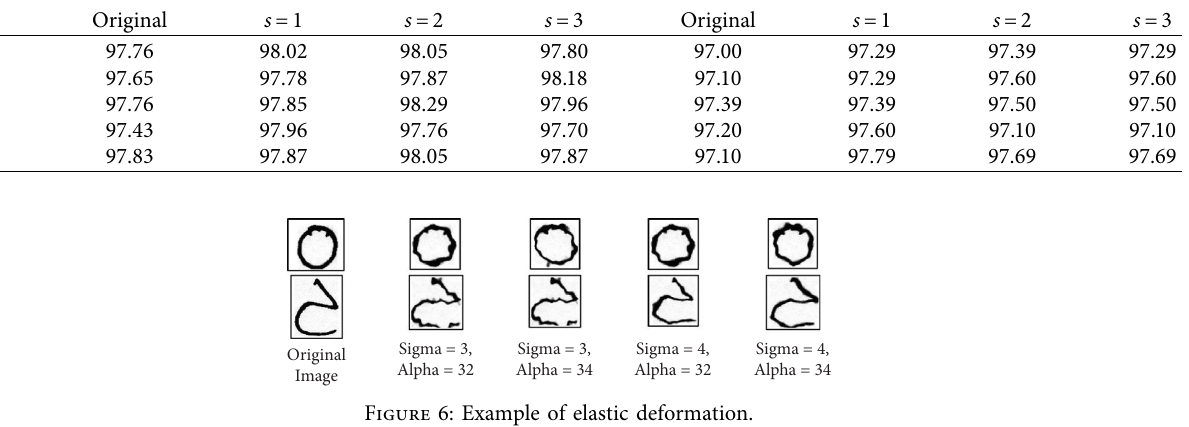
Figure 6: Example of elastic deformation.